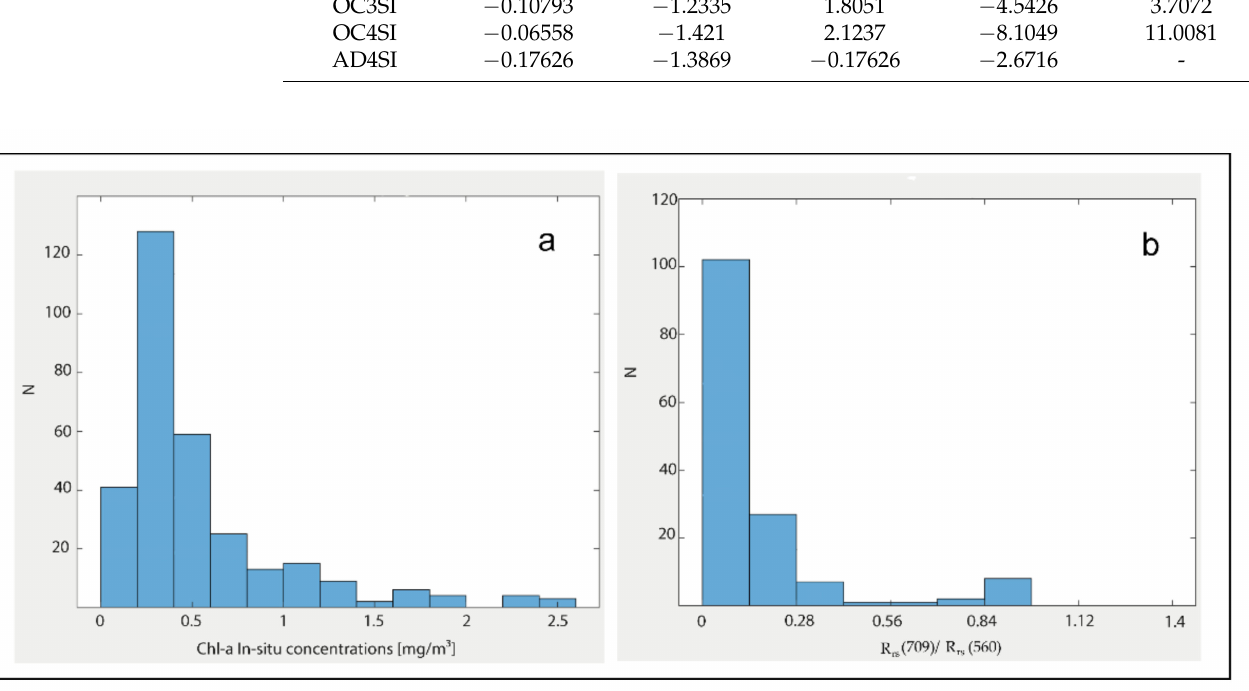
Figure 9. Distribution of in-situ ( a ) Chl- a concentration and ( b ) turbidity in the southeastern part of the